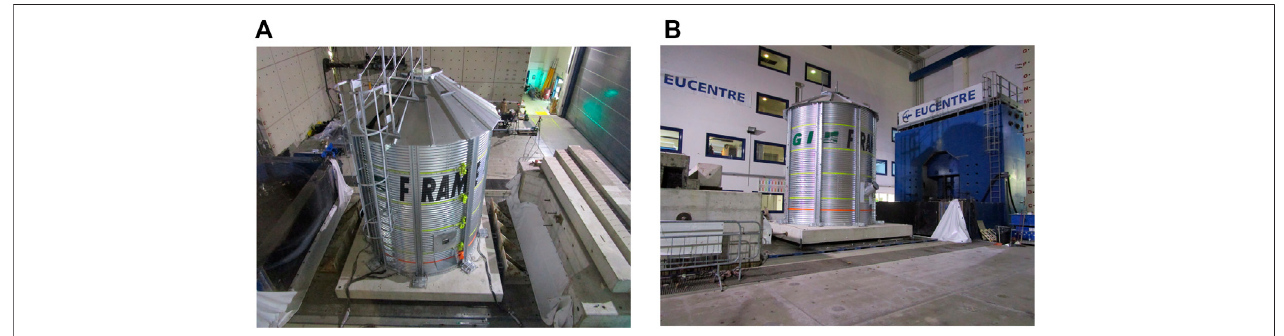
FIGURE 4 | The tested fl at-bottom steel silo of the SERA-SILOS project (Silvestri et al., 2021): (A) fully restrained and (B) seismically